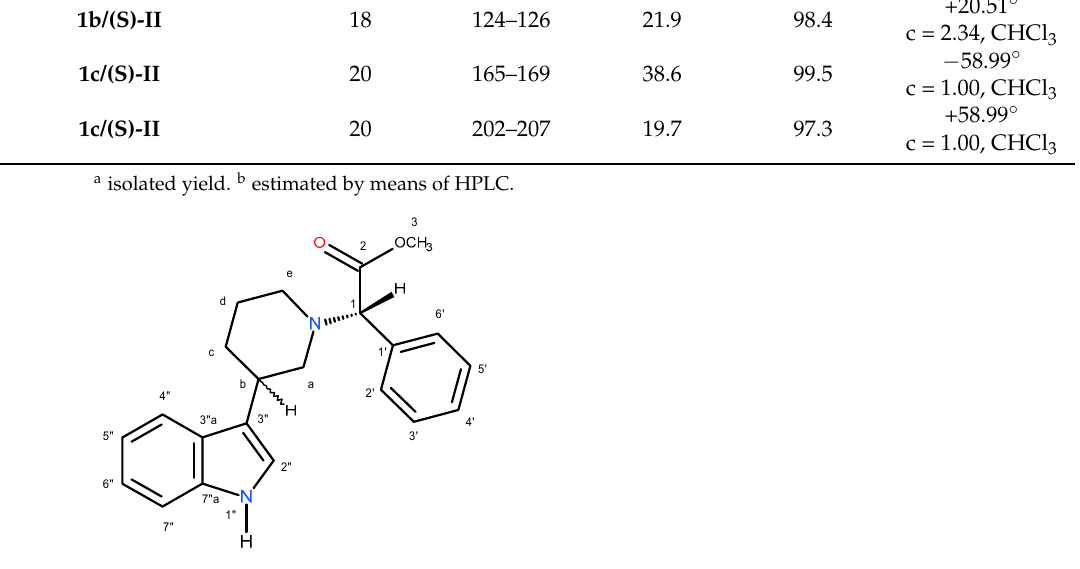
Figure 6. Numbering system for NMR spectra interpretation of compounds (3R,2S)-2a and (3S, 2S)- 3a . Table 2. Physico-chemical data of diastereomers 2a , 3a , 4a , 5a , 6b , 7b , 8c , and 9c .